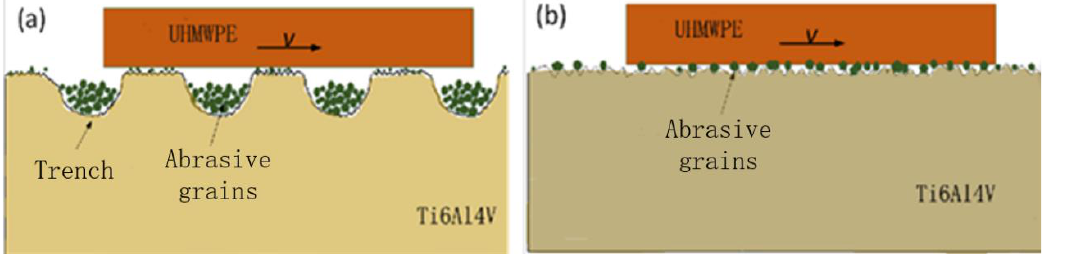
Figure 22. Schematic diagram of surface friction wear of different specimens. ( a ) Micro-shaped sur- face, ( b ) Smooth surface. surface, ( b ) Smooth